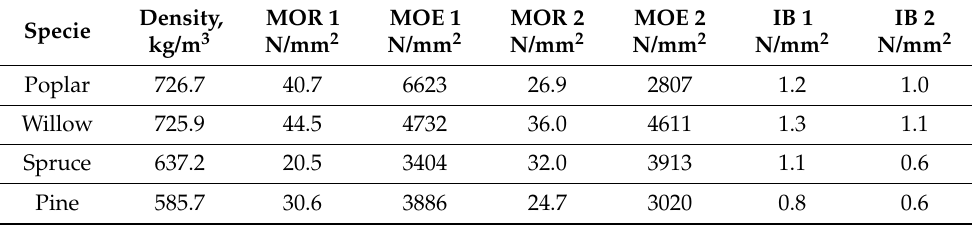
Table 2. OSB boards